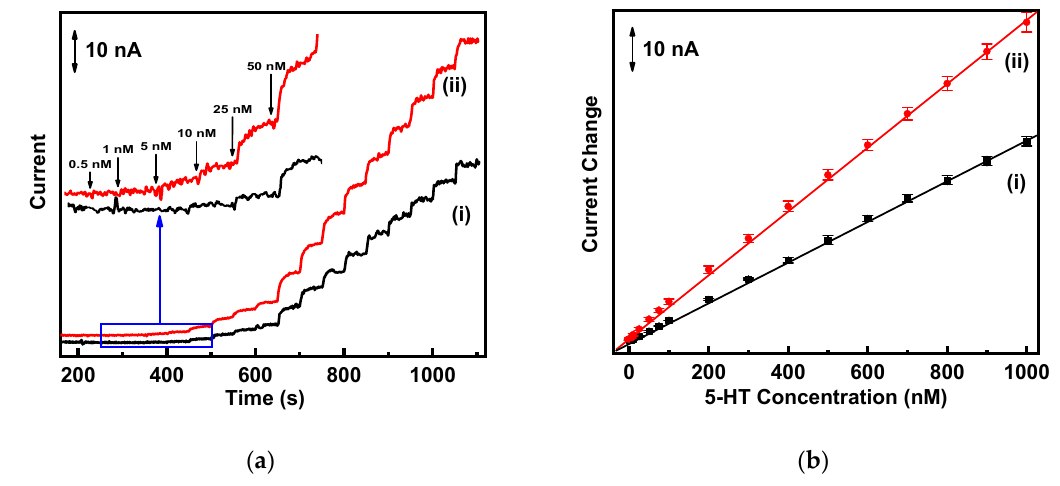
Figure 4. ( a ) Amperometric response of (i) bulk g-C 3 N 4 and (ii) g-C 3 N 4 nanosheets at 0.40 V in 0.1 M PBS (pH 7.0) with successive addition of 5-HT. Inset: The concentrations of 5-HT (0.5 nM, 1 nM, 5 nM, 10 nM, 25 nM, and 50 nM); ( b ) the corresponding calibration curves. Table 1. Comparison of the prepared sensor with previously reported studies for 5-HT detection. Modified